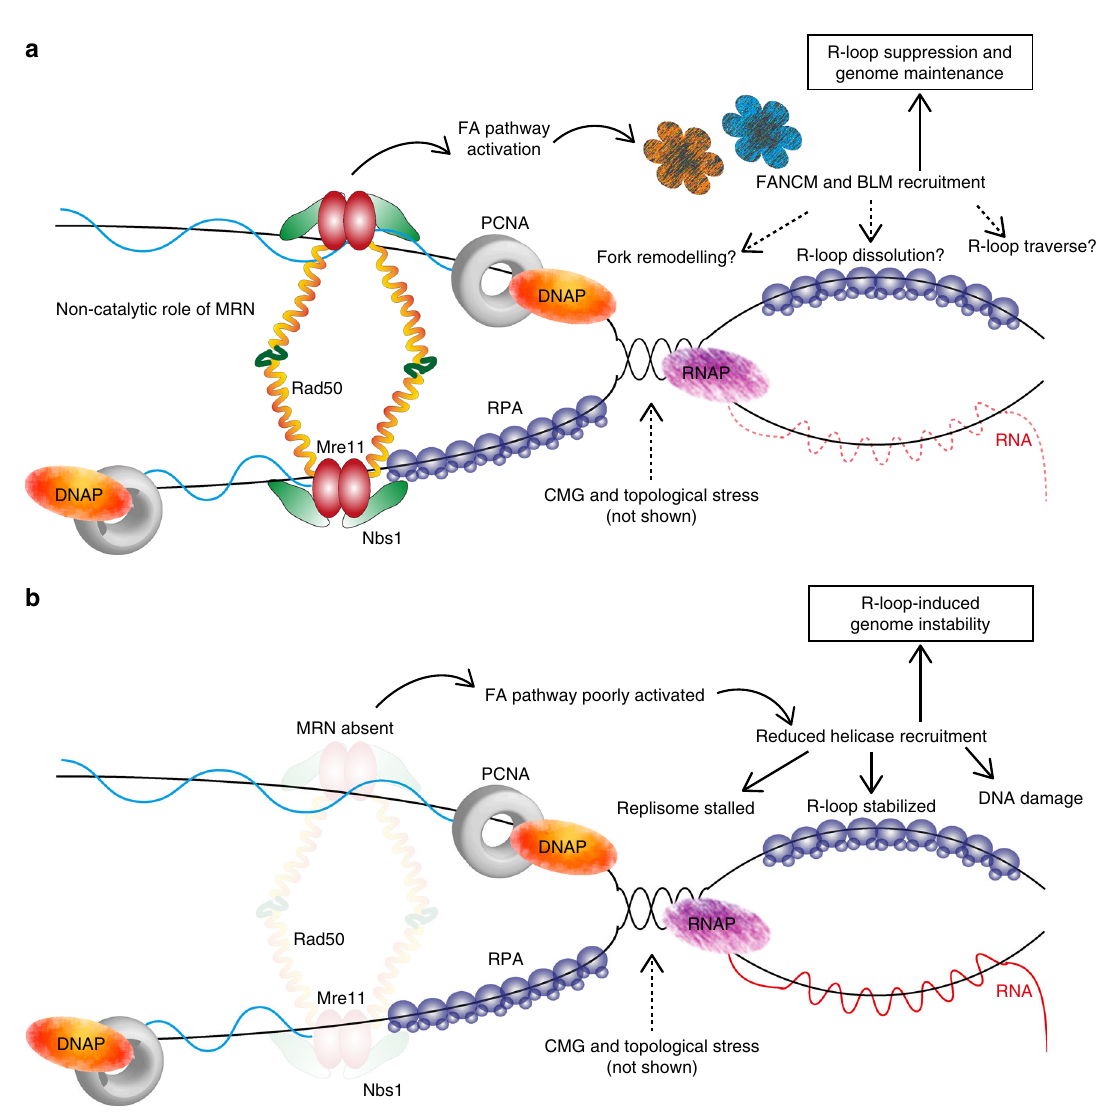
Fig. 7 Model of MRN function in R-loop tolerance and mitigation. a The MRN complex may play a structural role at transcription – replication con fl icts upstream of FA pathway activation and genome stability maintenance. Speculative models for how the FA pathway could resolve these con fl icts are indicated with question marks. b When MRN is depleted, the FA proteins are poorly recruited to transcription – replication con fl icts, R-loops are stabilized, DNA is damaged and genome instability